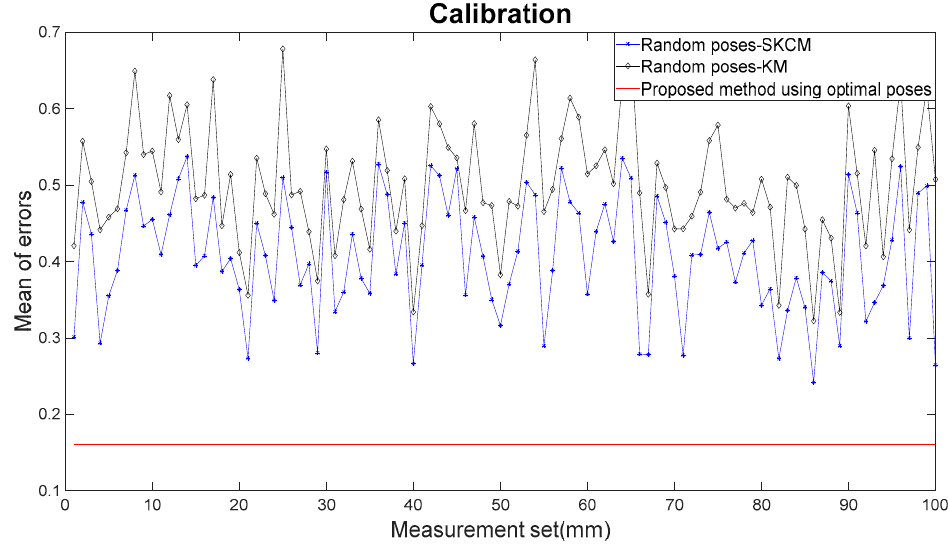
Figure 7. Result of the calibration process.